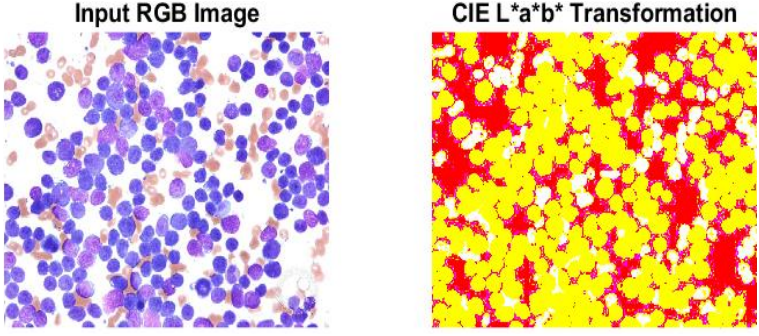
Figure 5. CIE L*a*b* transformation from RGB image.